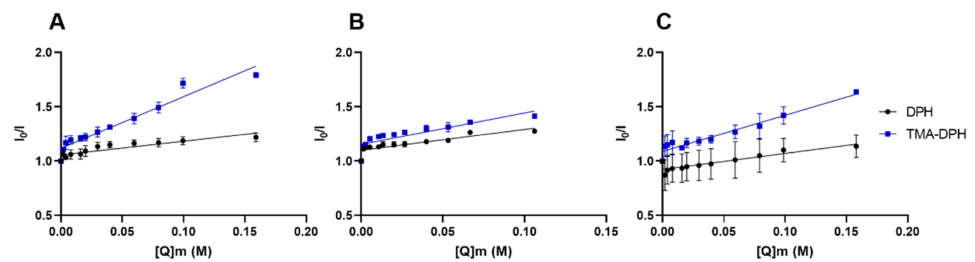
Figure 3. Stern–Volmer graphs showing the quenching of DPH and TMA-DPH fluorophores in the studied models: ( A ) DMPC, ( B ) DMPC:Chol:SM pH 6.5, and ( C ) DMPC:Chol:SM pH 7.4 at 37 ◦ C, with increasing doses of